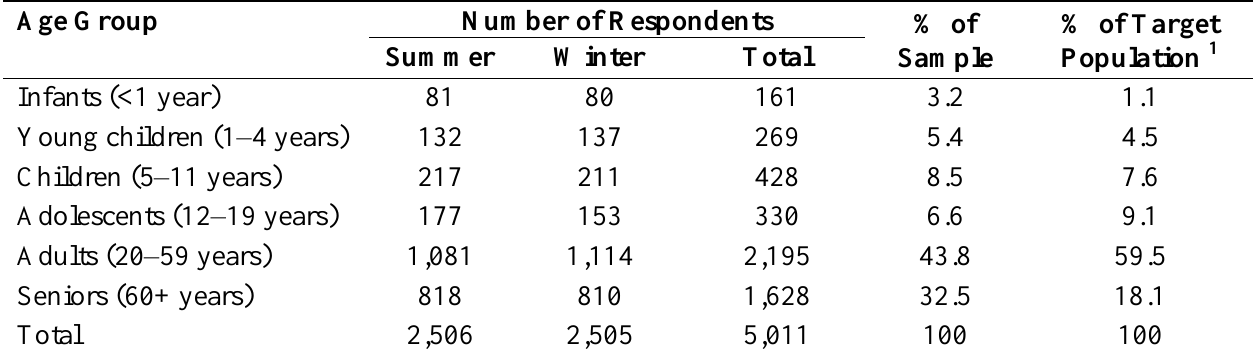
Table 2. Distribution of CHAPS 2 respondents by age and